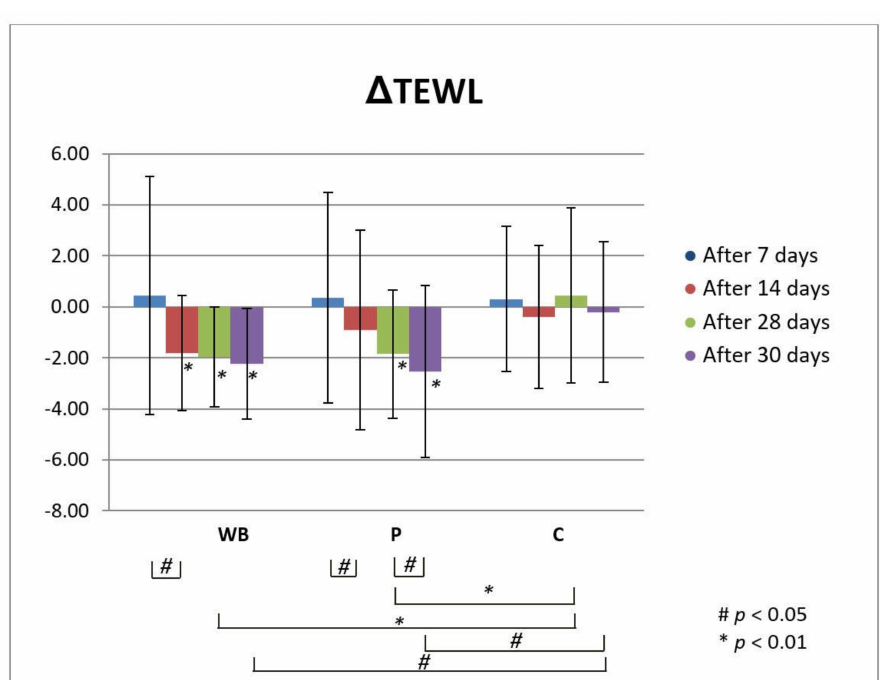
Figure 3. In vivo determined absolute changes relative to basal values of TEWL for investigated creams (active cream—WB, placebo cream—P) after 7, 14, 28 days of application and 2 days after cessation of application, compared to untreated control (C). Significant differences are being marked with # ( p < 0.01) and * ( p < 0.05).